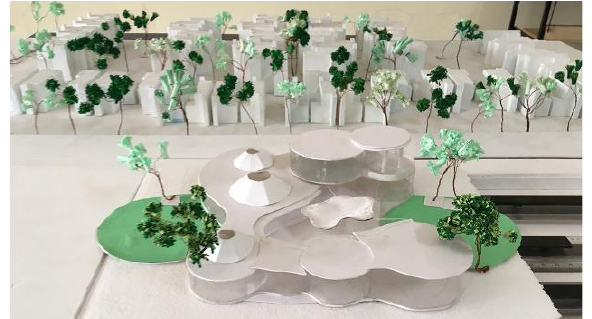
Figure 8. The studio site model in the background. In the foreground is the final model of Mehak Madan. Photo Karassowitsch.